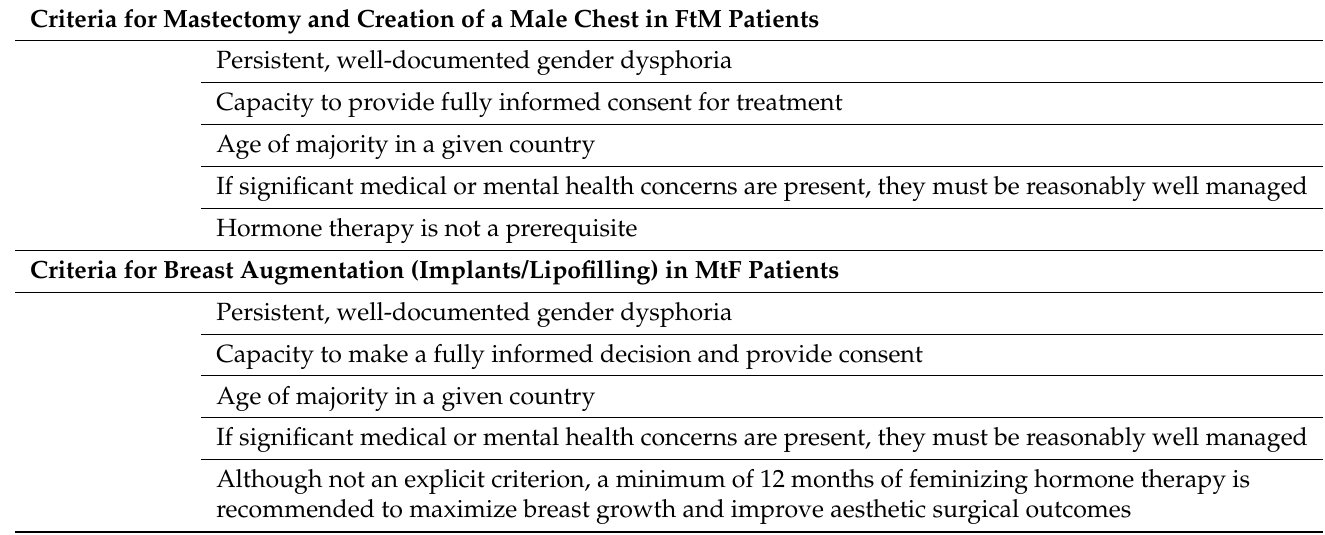
Table 3. Criteria for breast/chest surgery (one referral) [1].